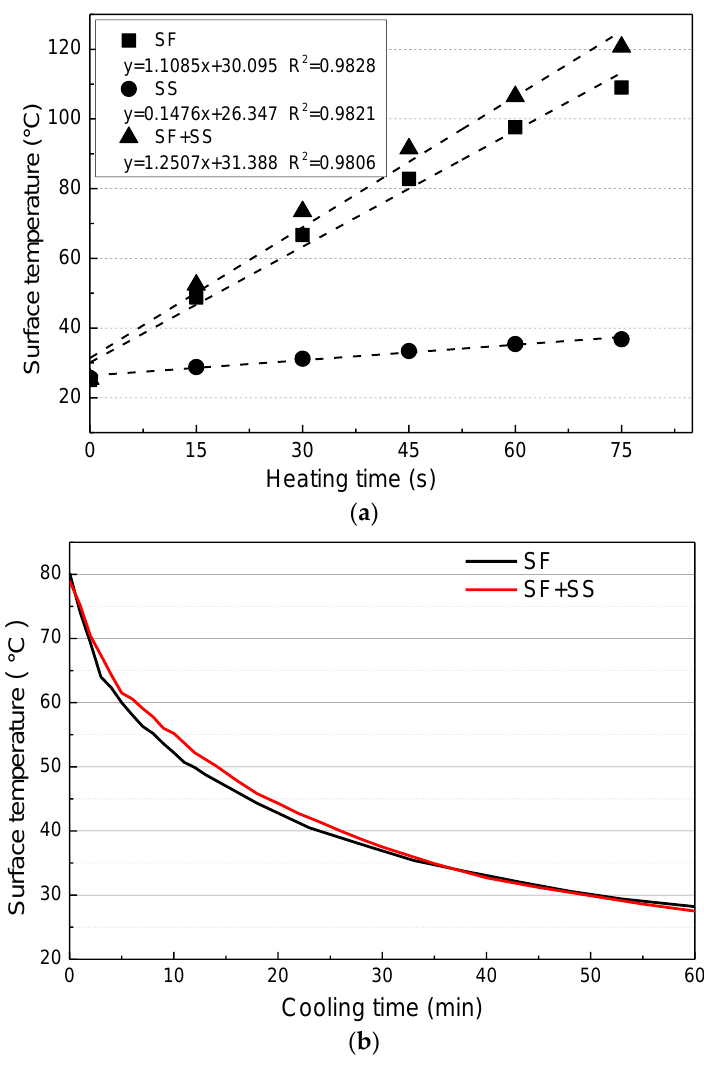
Figure 7. Temperature-versus-time curves of asphalt mixtures with induction heating. ( a ) During heating; ( b ) During cooling.